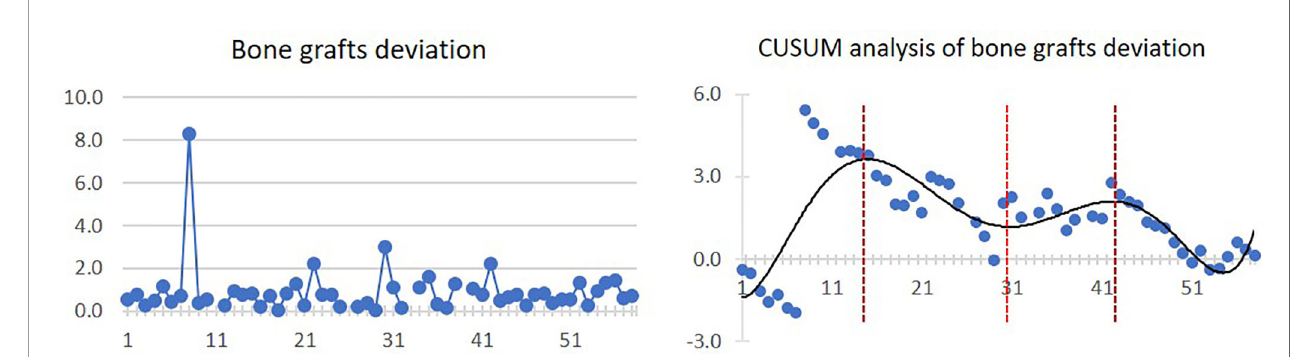
FIGURE 5 | Linear graph and CUSUM analysis of bone grafts deviation in CAJR applying patient-speci fi c surgical plates. The black line represents the curve of best fi t in a general model with equation, y = 5E − 08 x 6 − 8E − 06 x 5 + 0.0005 x 4 − 0.0148 x 3 + 0.1689 x 2 − 0.2517 x − 1.307, R ² =